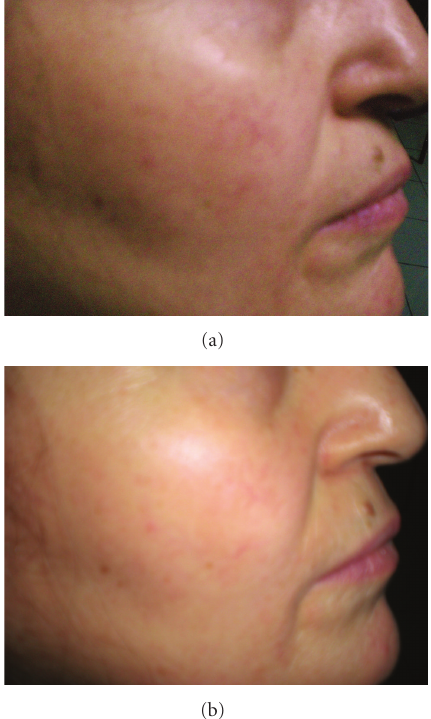
Figure 1: (a) Facial telangiectasia of a patient before treatment, (b) facial telangiectasia in the patient after fifth session of the treatment, Category-I (cleared lesion).